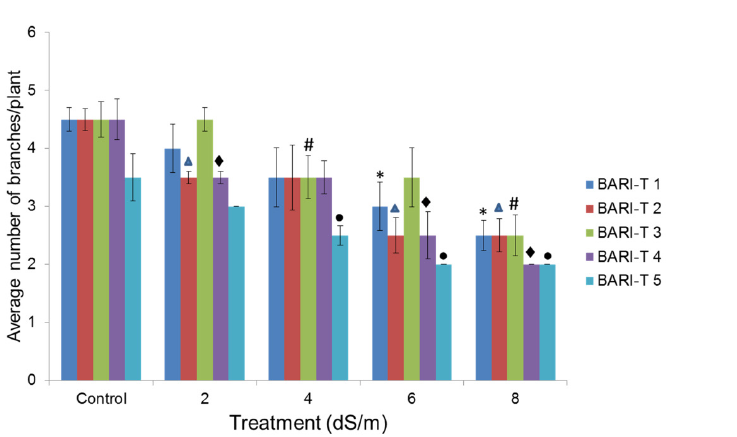
Fig. 6. Effects of NaCl-salinity on number of branches in five BARI-T plants. Error bars indicate mean ± SD (n=3). Asterisk *, , #, ♦ , and • denote a significant difference between the saline-treated group and control group of BARI-T 1, BARI-T 2, BARI-T3, BARI-T 4 and BARI-T 5, respectively at